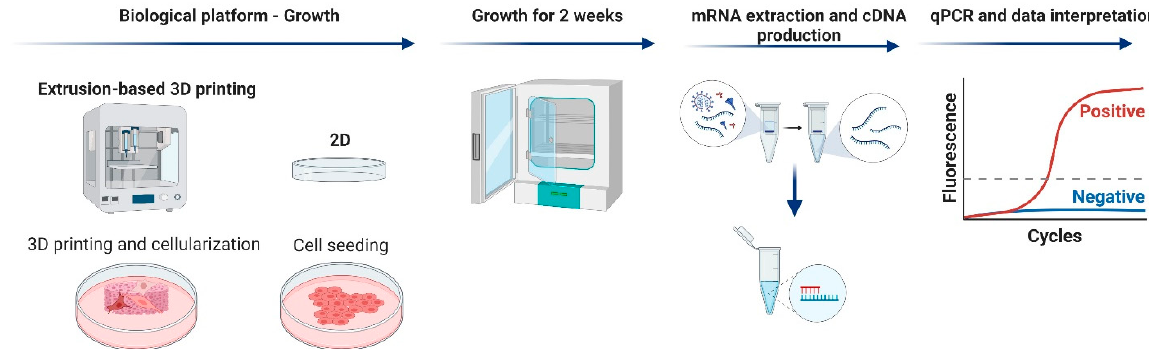
Figure 1. Gene-expression-analysis process. TEMPO CNF scaffolds were 3D-printed using an extrusion printer. Detroit551 fibroblasts were added to the scaffolds and cultured for 2 weeks. As a control, cells were cultured in conventional plastic cell culture dishes. The mRNA was extracted from the cells; reverse transcription was performed to produce cDNA and qPCR was performed with marker genes for wound healing and proliferation.